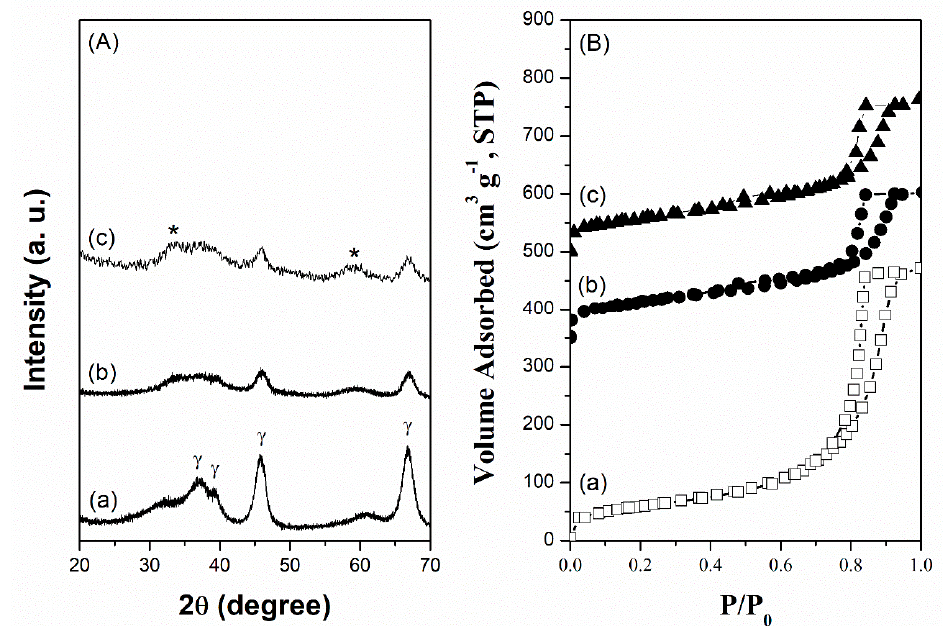
Figure 1. ( A ) powered XRD patterns, ( B ) N 2 adsorption-desorption isotherms of mesoporous sulfide catalysts: ( b ) CoMo/ γ -Al 2 O 3, and ( c ) NiMo/ γ -Al 2 O 3 catalysts, in comparison to those of a supporting material: ( a ) γ -Al 2 O 3 . The asterisk and gamma ( γ ) represent the characteristic peaks of Co-incorporated MoS 2 -like slabs (or Ni-incorporated counterpart) and gamma-alumina framework, respectively.